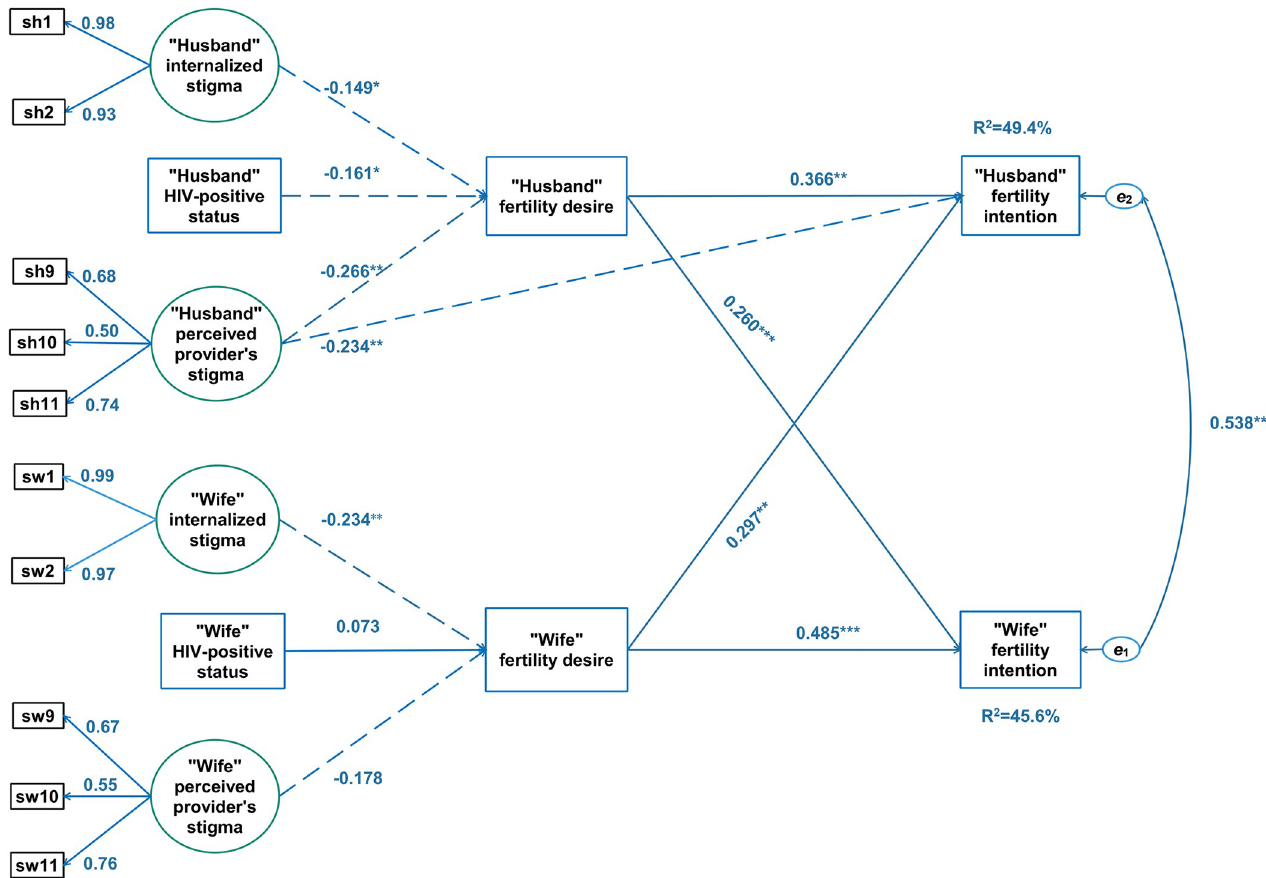
Fig 2. Associations of wives and husbands’ childbearing internalized and provider stigma and fertility intention through fertility desire based on actor- partner interdependence mediation (APIMeM) model. Significant ( p < .05) positive effect, significant ( p < .05) negative effect, ��� : p < .01, �� : p < .05; R 2 : Squared multiple correlation, e1 and e2: Residual